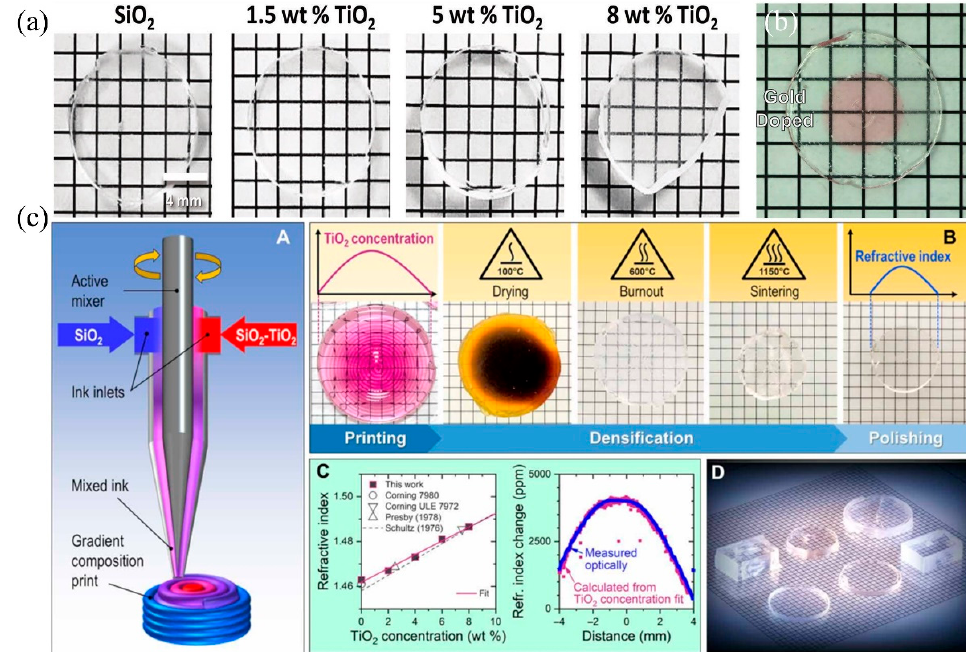
Figure 5. ( a ) Related glass sample with a typical polish, which is fully dense and prepared through DIW. ( b ) Two nozzles containing gold and non-gold silica ink were used to print the core-shell structure. ( c ) Process and samples of additive manufacturing of gradient index (GRIN) silica-titania glass via DIW [14]. ( a ) Reprinted with permission from ref. [74]. ( b ) Reprinted with permission from ref. [13].